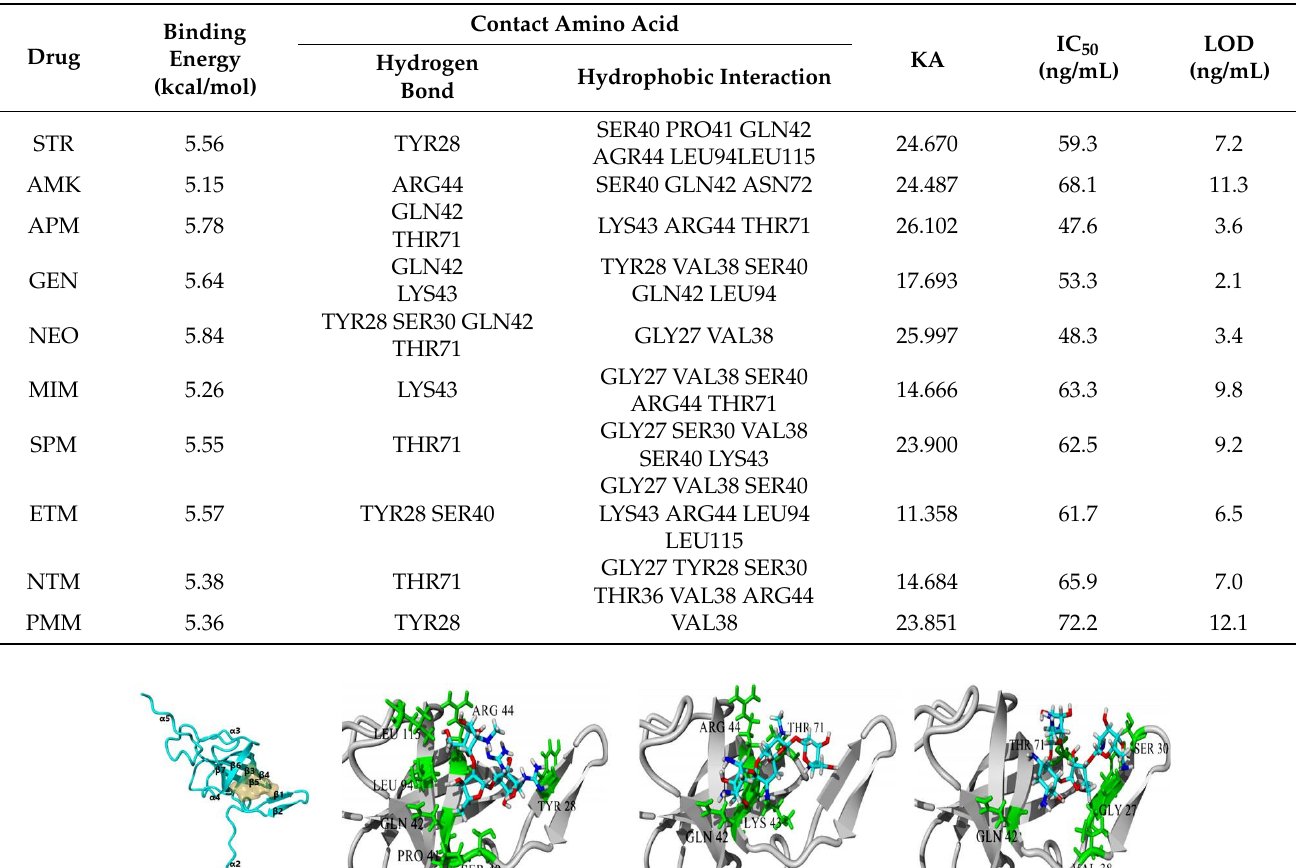
Table 1. Docking results, absolute affinity constants (KA) and determination parameters for the 10 AGs.